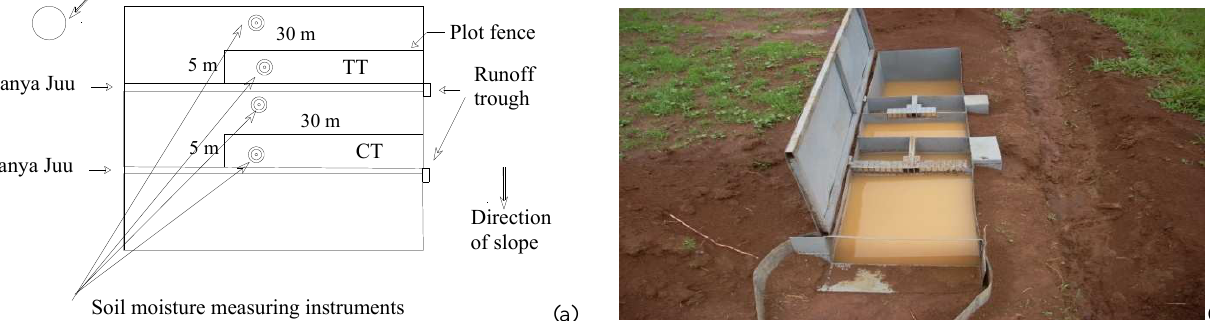
Fig. 3. (a) Layout of a single replication (one farmer’s field). The three sides of the 5m × 30m area is bound by a galvanized iron sheet fence that was inserted 15 cm in to the soil with 10 cm height above the ground. The lower side is bound by the Fanya juu . Runoff was collected from this area. Locations of CT and TT were randomly selected for each block. (b) Runoff trough used in the study. The picture was taken following a high rainfall day on 31 August 2010. About 2m 3 (13mm) of runoff was recorded by the trough from a 36mmd − 1 rainfall event on a field with TT wheat.